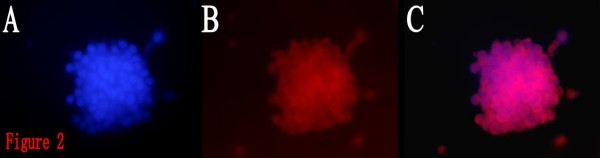
Immunofluorescent identification of BTSCs for CD133 (Cy3, × 200). 2A: DAPI. 2B:CD133. 2C:Merge. It showed the cell spheres were CD133 positive.